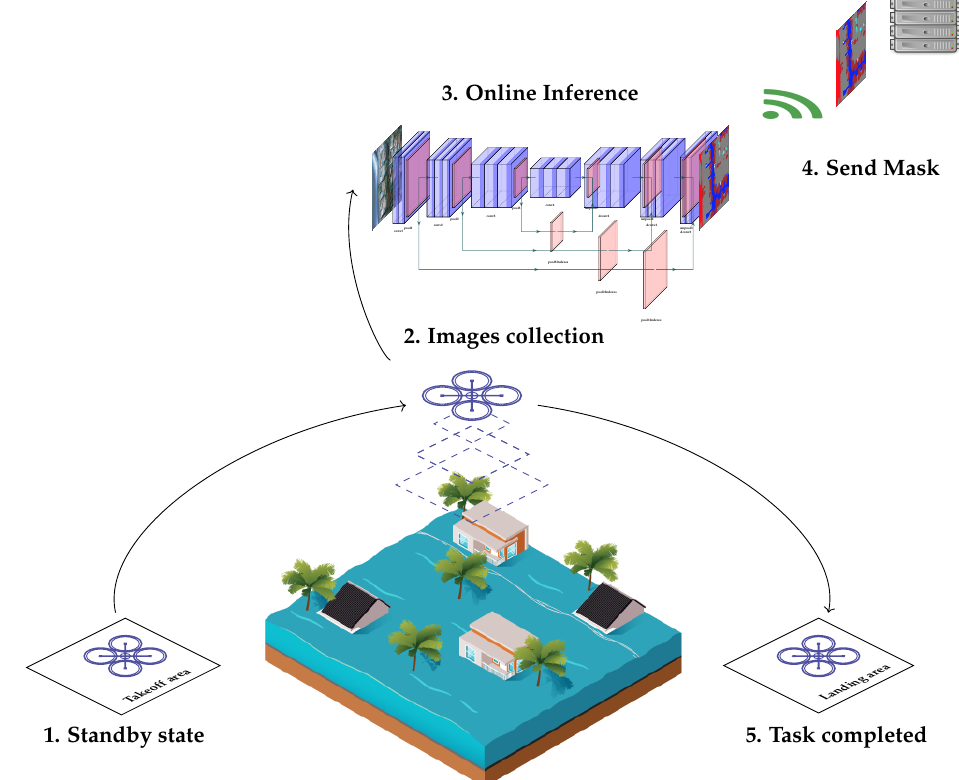
Figure 3. Overview of our image collection and processing